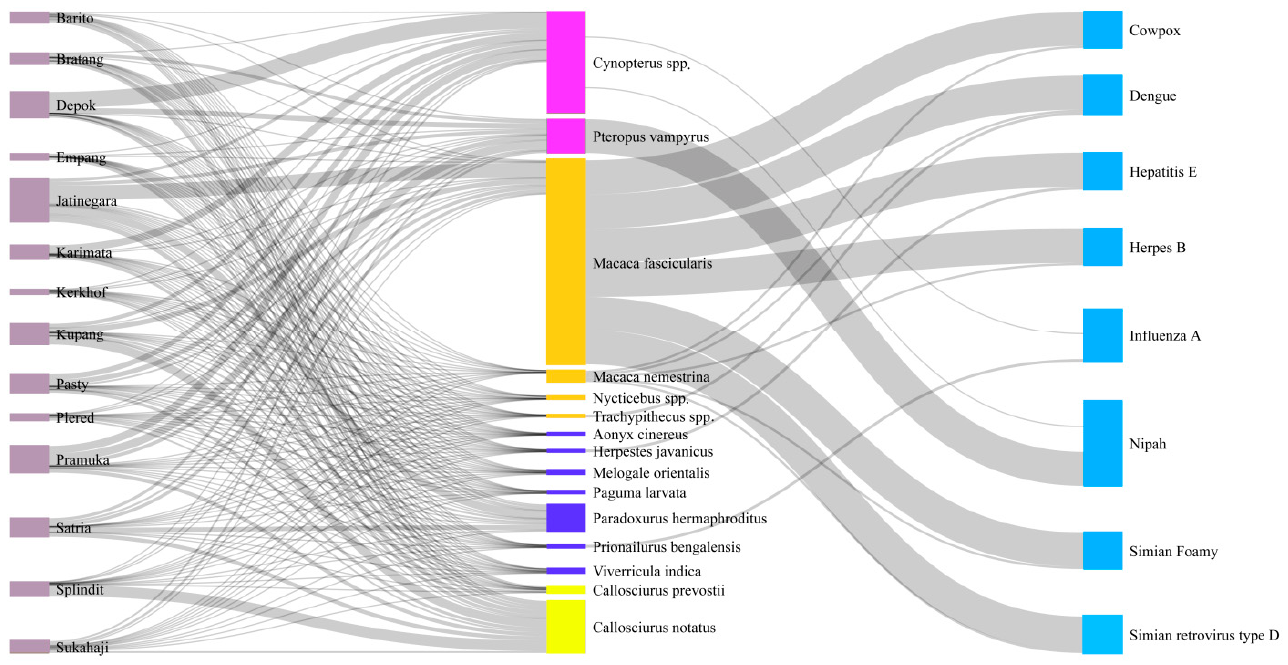
Figure 3. Sankey network diagram illustrating the 14 surveyed wildlife markets (purple), the mammal taxa (pink = bats, orange = primates, navy blue = carnivores, yellow = rodents), and the viruses (blue) these animals have the potential to host and share by co ‐ occurring in the same markets.